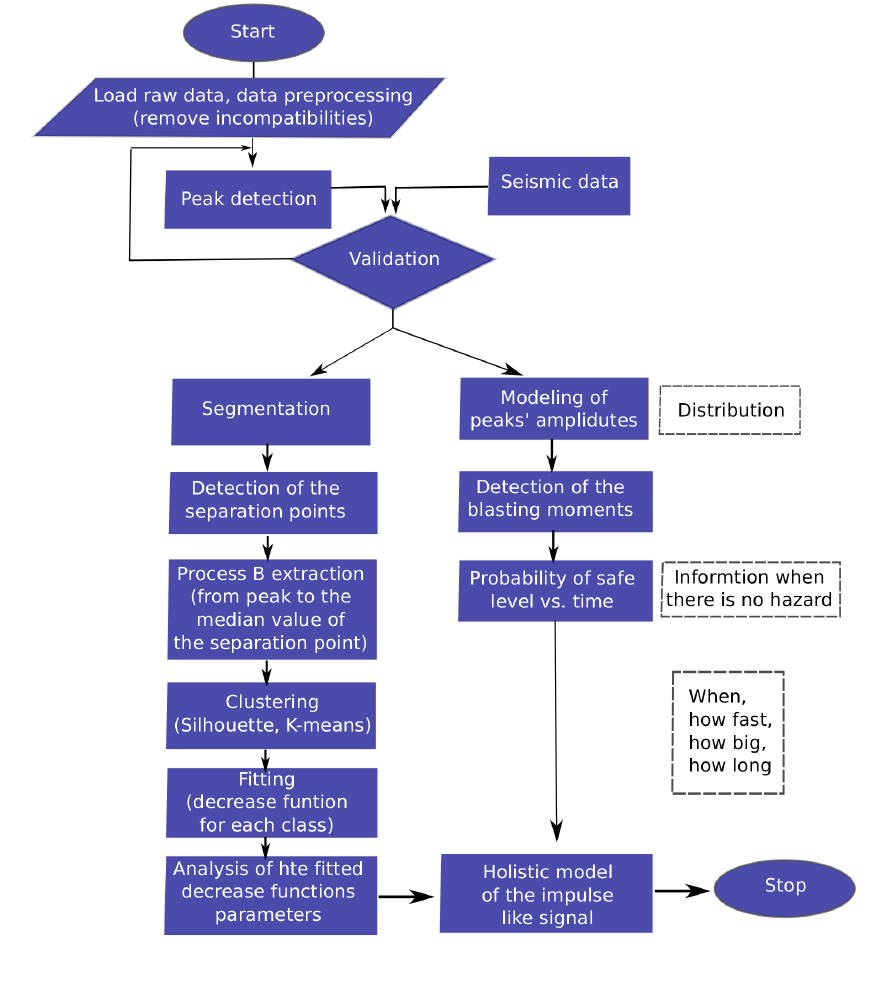
Figure 5. The block diagram of real data